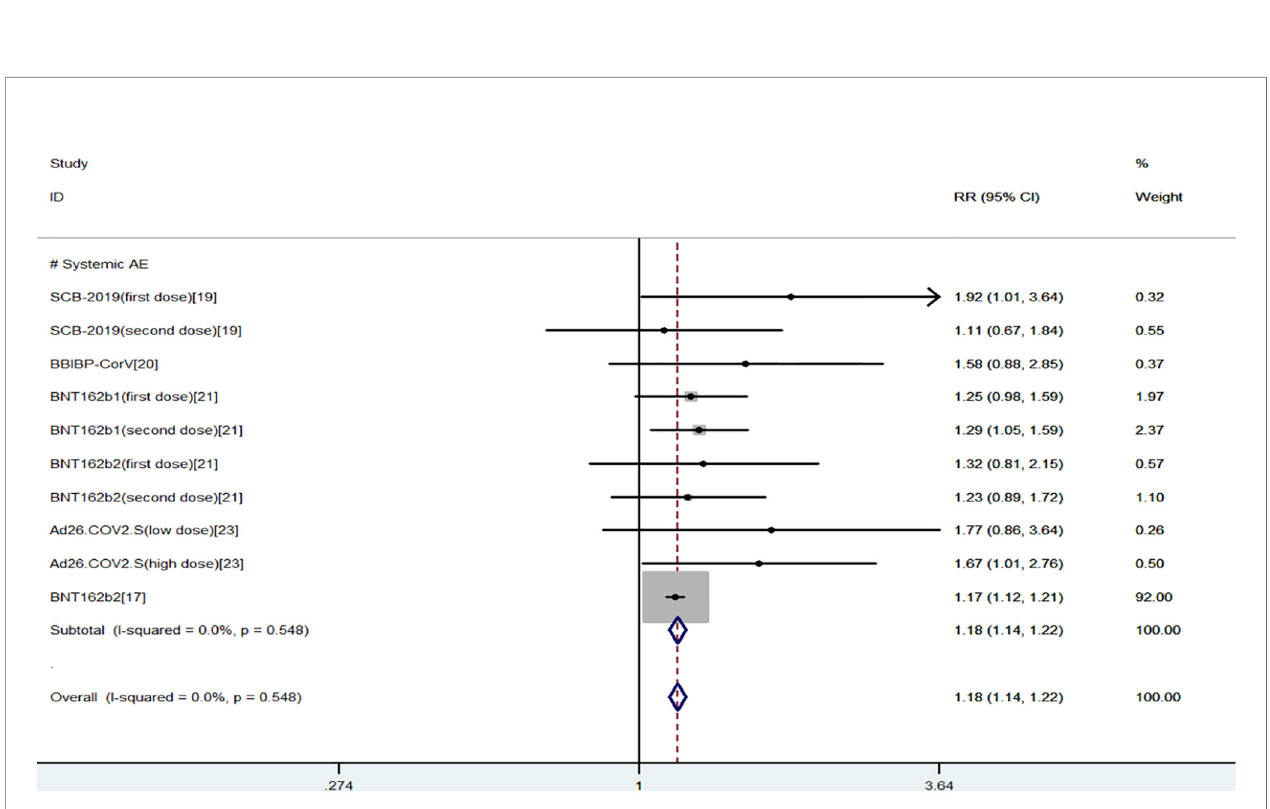
FIGURE 5 | Meta-analysis of systemic AEs between the experimental group (young adults) vs control group (older adults).